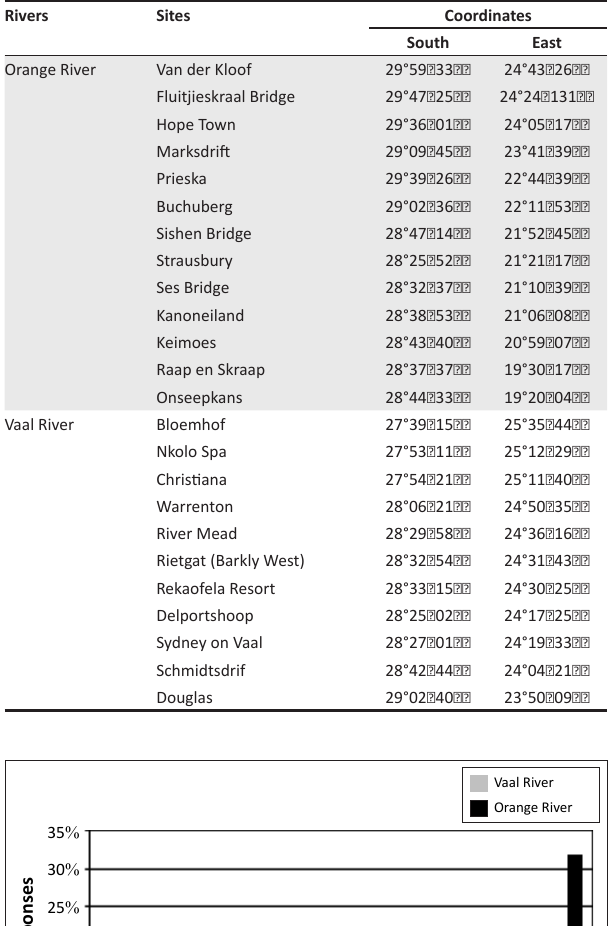
TABLE 1: Sites along the Orange and Vaal Rivers at which seasonal surveys of blackfly abundance were conducted during 2006–2007. Rivers